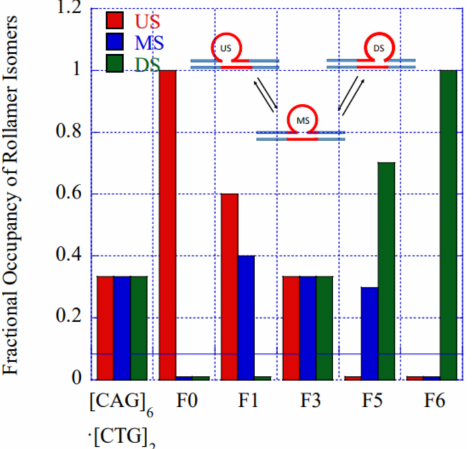
Figure 5. Impact of lesion position on the fractional occupancy of loop isomers at 25 ◦ C derived by fitting to our semi-empirical model. In the absence of lesion induced local changes in the rollamer energy landscape (e.g., in the [CAG]6 · [CTG]2 parent or in [CAG]6-F(3) · [CTG]2) all three loop isomers are occupied equally ( = 0.33). (US = UpStream, MS = MidStream, and DS =